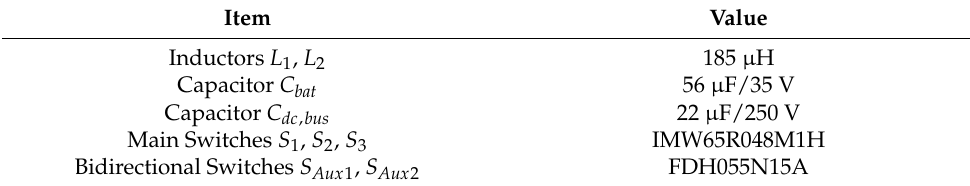
Table 2. Parameters of the experimental system.